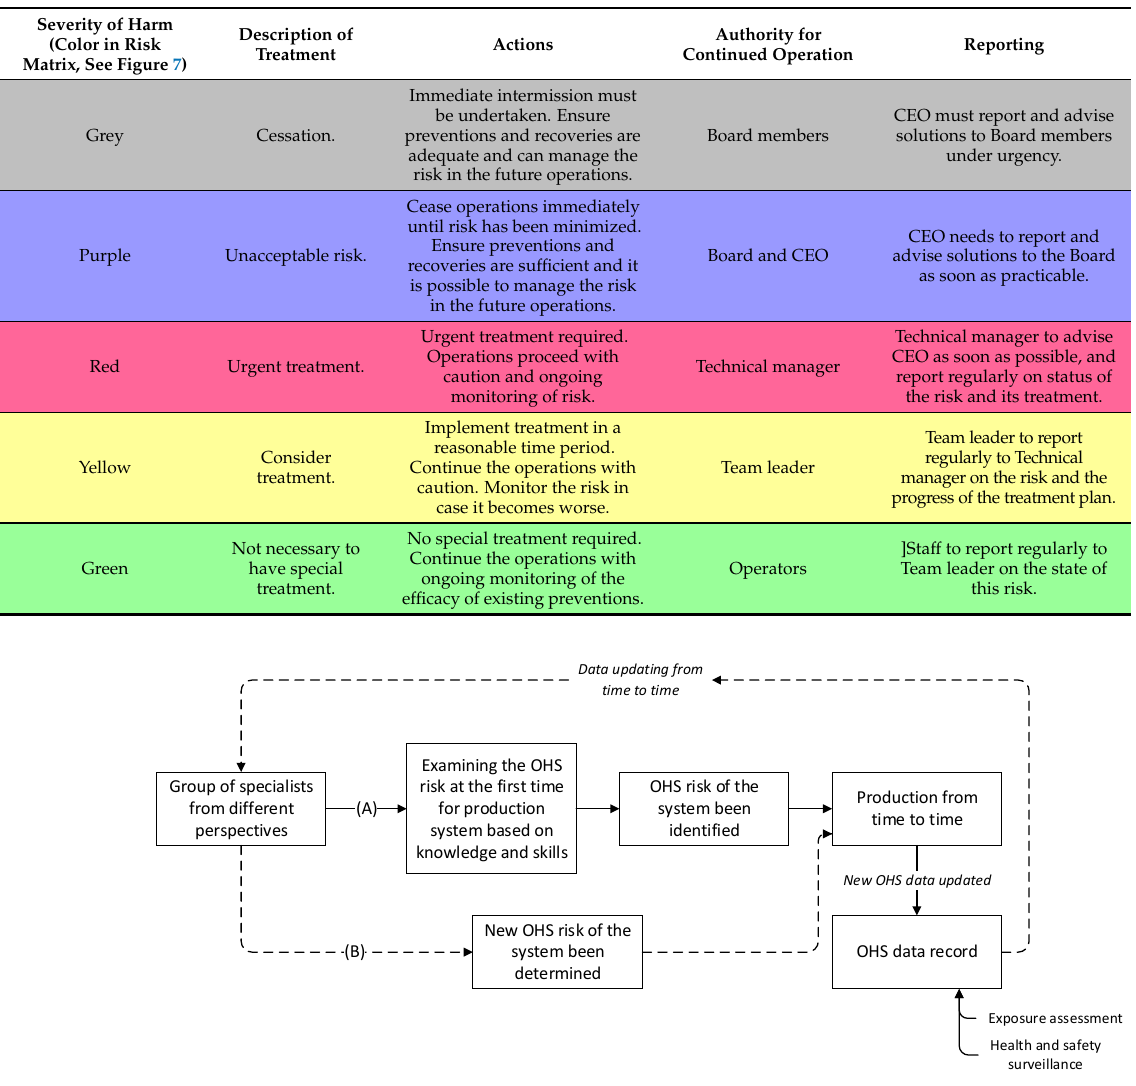
Table 3. Risk appetite response scale.